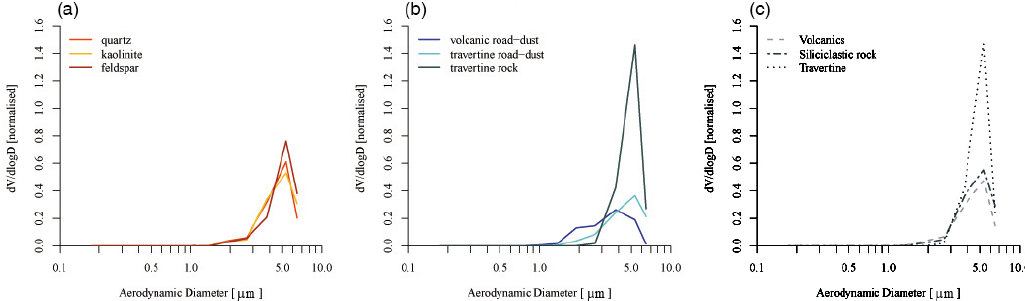
Figure 4. Normalized volume size distributions of most abundant silicates (a) , calcite (b) , and local dust types (c) in the PM 10 fraction. Calcite is differentiated by natural (travertine) or anthropic (road dust) origin.